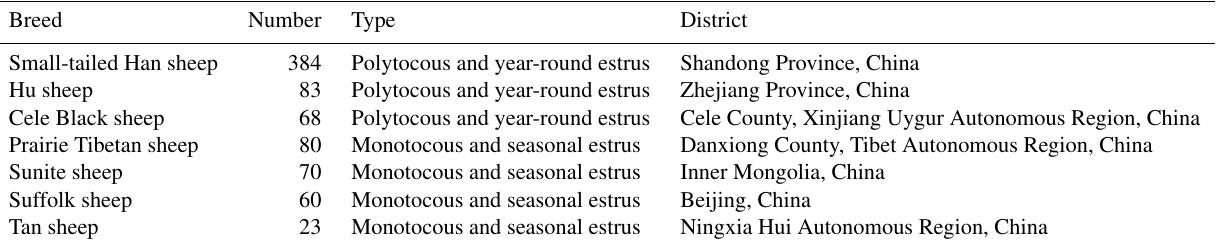
Table 1. The number and source location of ewes used in this study.